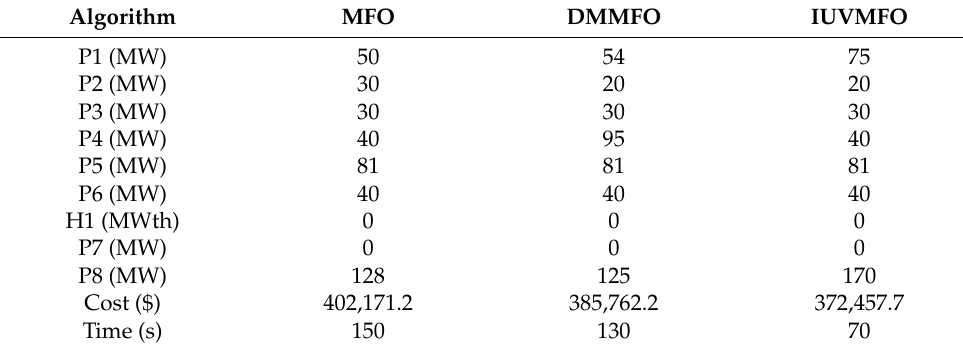
Table 12. Comparison of results for economic dispatch of